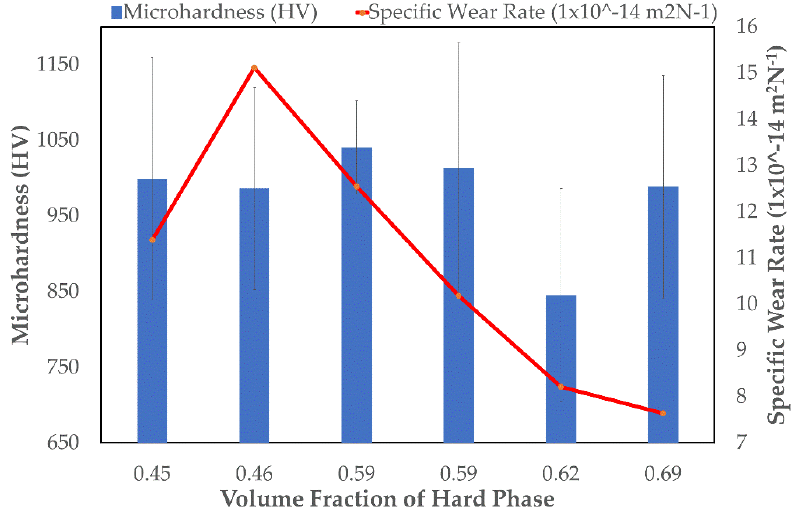
Figure 7. The relation between volume fraction of hard phase, microhardness and specific wear